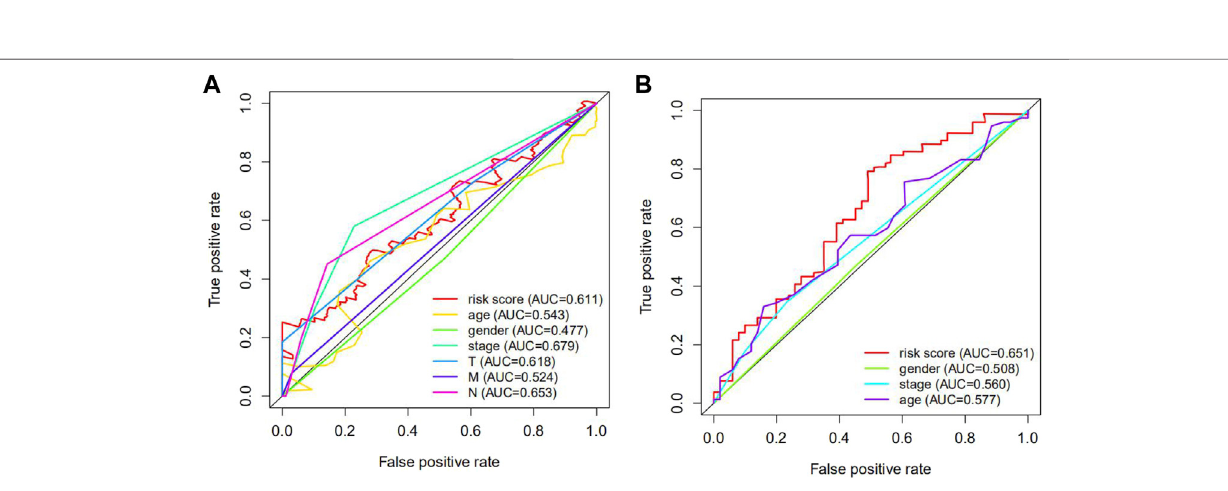
Frontiers in Molecular Biosciences |